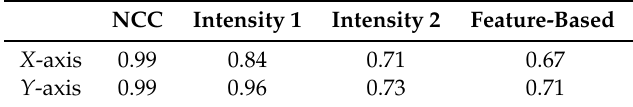
Table 1. Cross-correlation between image registration algorithms for ROI 1 and ROI 3 in the X -axis and the Y -axis.